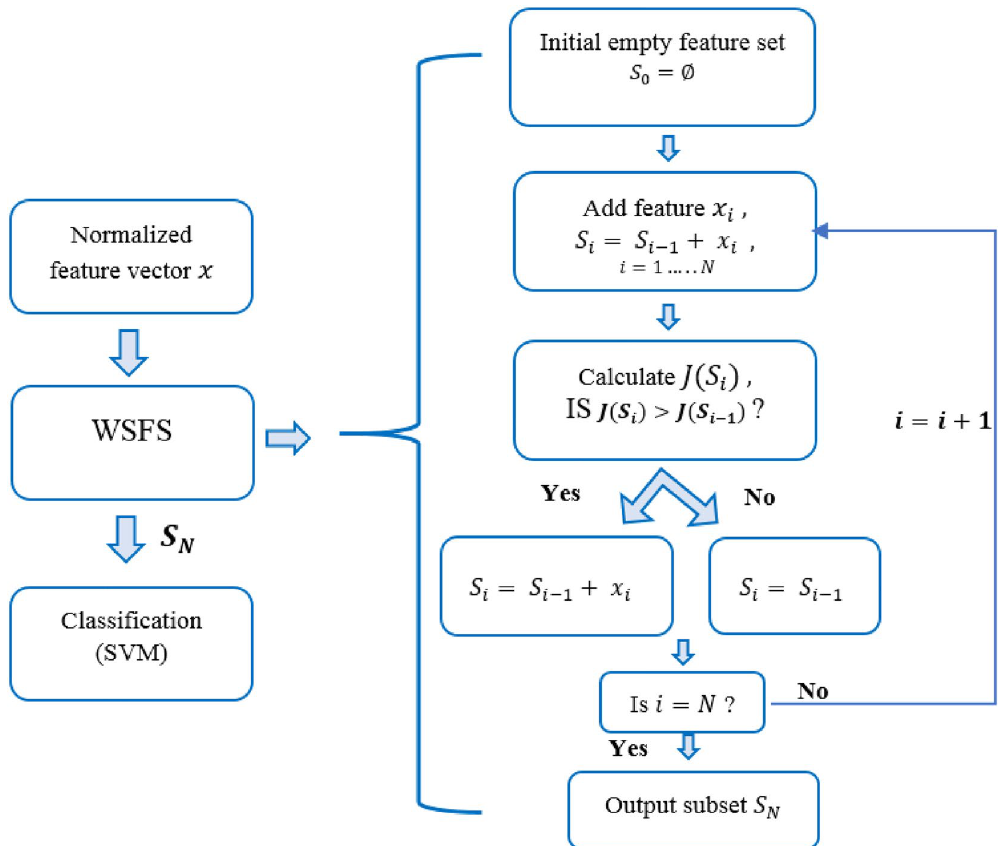
Figure 4. Classification steps and the weighted sequential forward selection